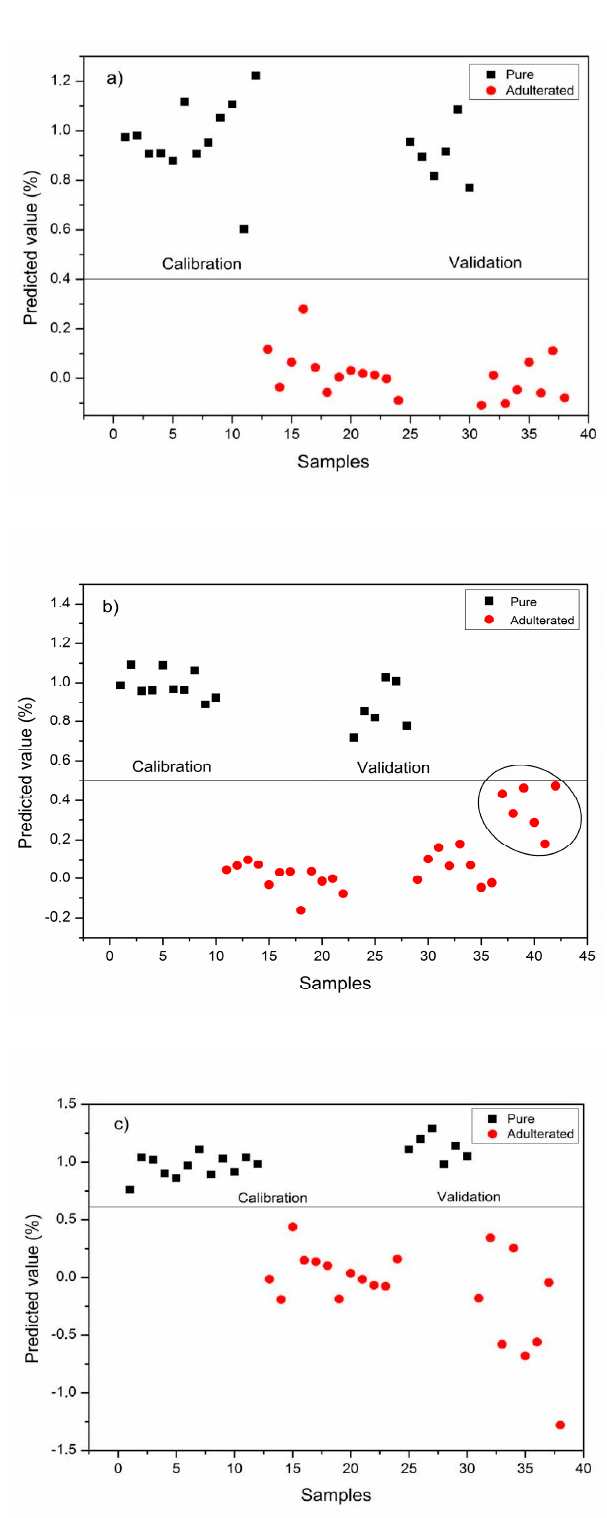
Figure 3. Partial least squares-discriminant analysis (PLS-DA) models for pure and adulterated pekmez samples. ( a ) Grape pekmez, ( b ) carob pekmez, ( c ) mulberry pekmez. PLS-DA classification parameters for different pekmez types are seen in Table 1. According to PLS-DA results, high sensitivity (100%), specificity (100%) and model efficiency (100%) values were obtained for grape, carob and mulberry pekmez samples. These classification accuracy results were